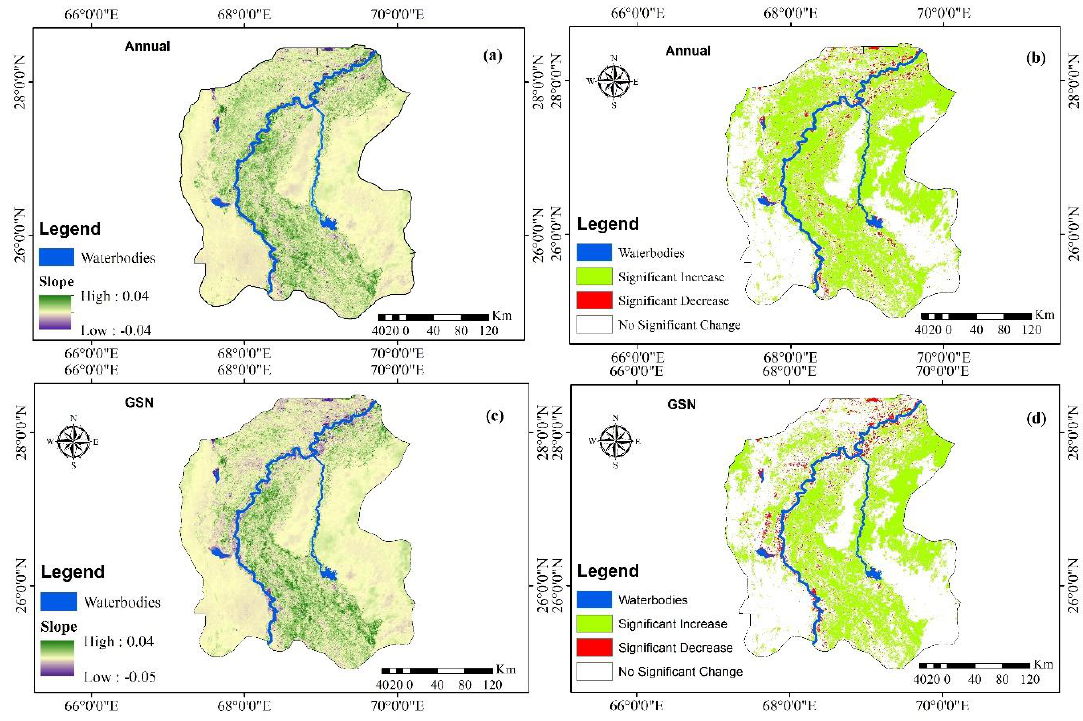
Figure 4. ( a ) Annual NDVI linear regression model (LRM) slope from 2000 to 2017, ( b ) annual distribution of significant increasing and decreasing trends ( p < 0.05), ( c ) Growing Season NDVI LRM slope from 2000 to 2017 ( d ), Growing Season distribution of significant increasing and decreasing trends ( p < 0.05).